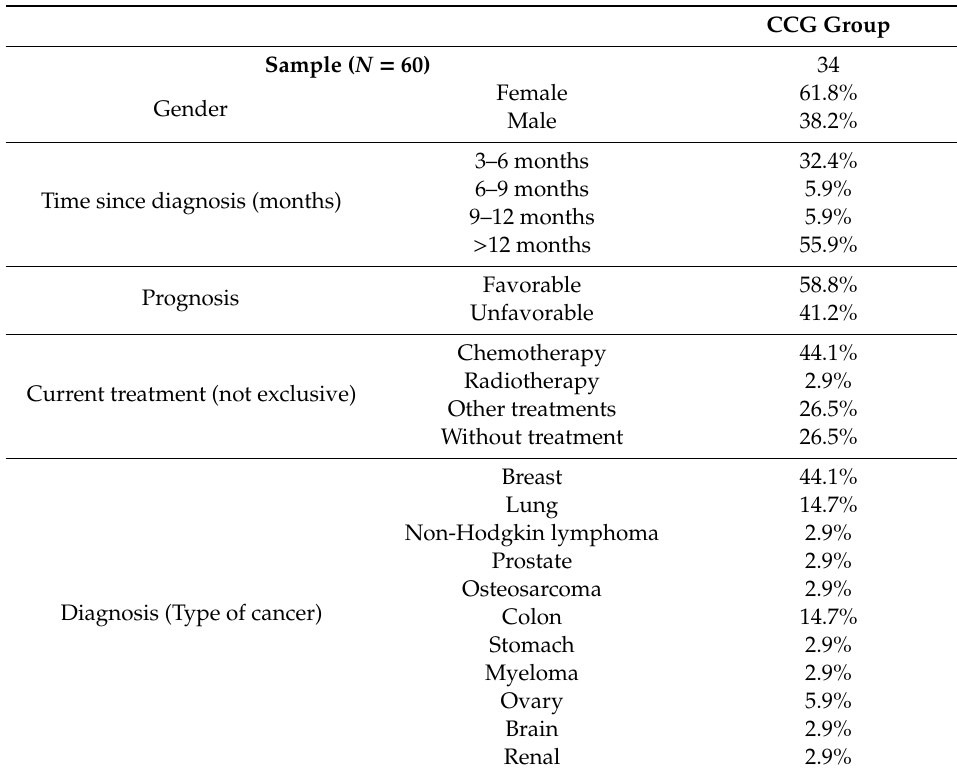
Table 2. Characteristics of cancer